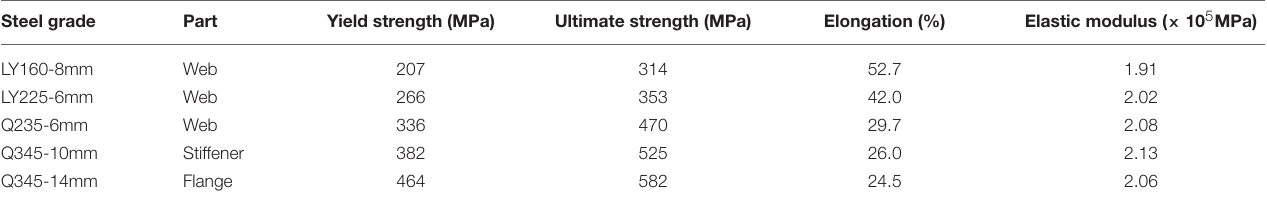
TABLE 2 | Mechanical properties for steel of metallic